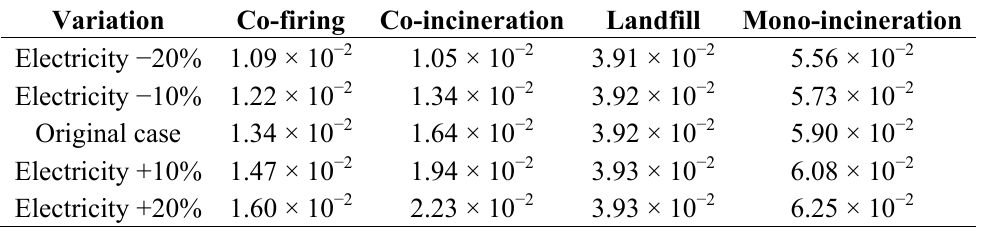
Table 4. Results of single scores for electricity consumption variances.